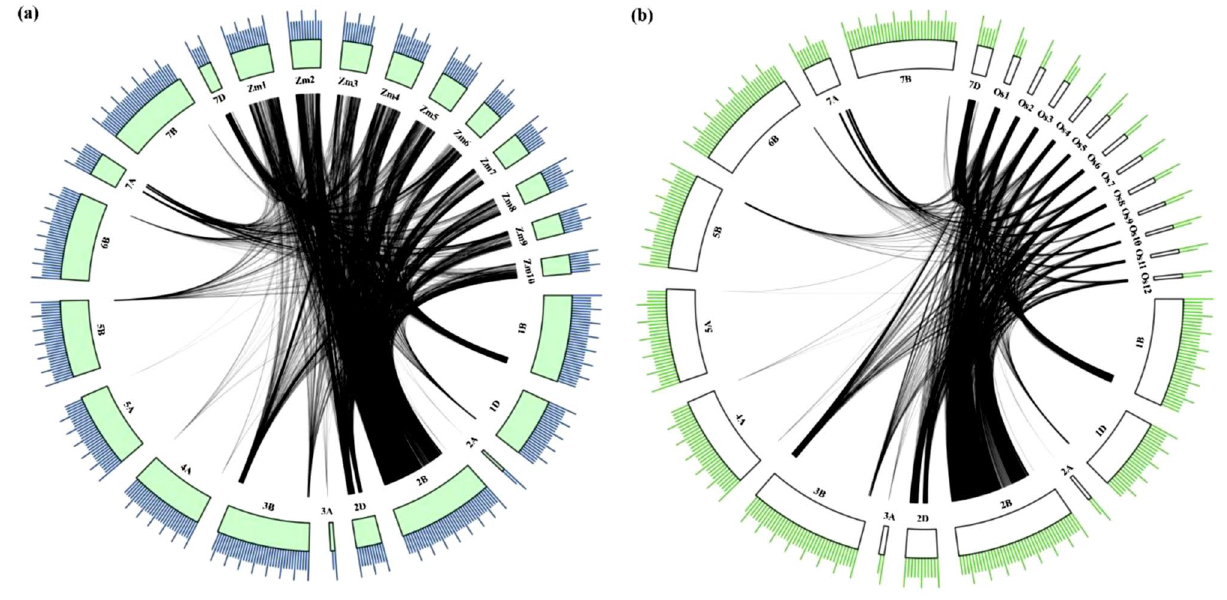
Figure 6. Syntenic relationship of genes available from the wheat MQTL regions with the ( a ) maize and ( b ) rice genomes. The physical sizes of the chromosomes are indicated by the ruler drawn above on them, with larger and smaller tick marks at every 100 and 20 Mbp,